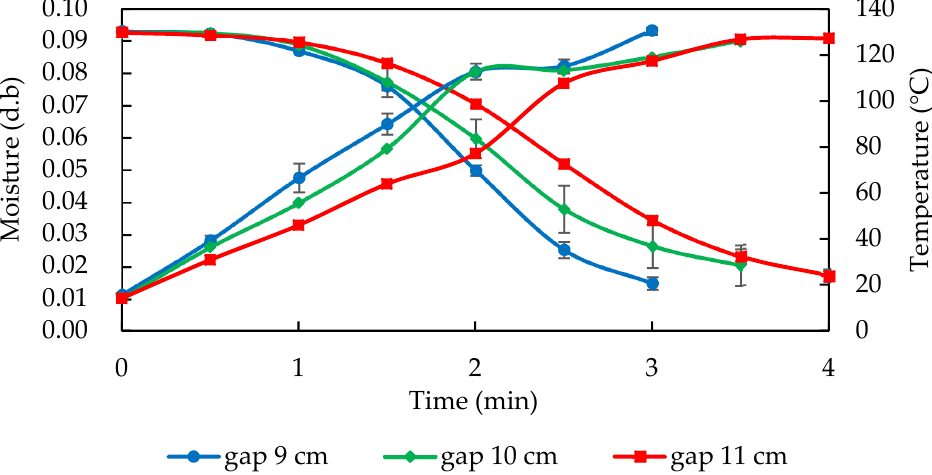
Figure 5. The drying and temperature curves of 1 kg almonds during 5 kW, 40.68 MHz RF roasting at different electrode gaps. Data are expressed as mean ± S.D. ( n = 3).